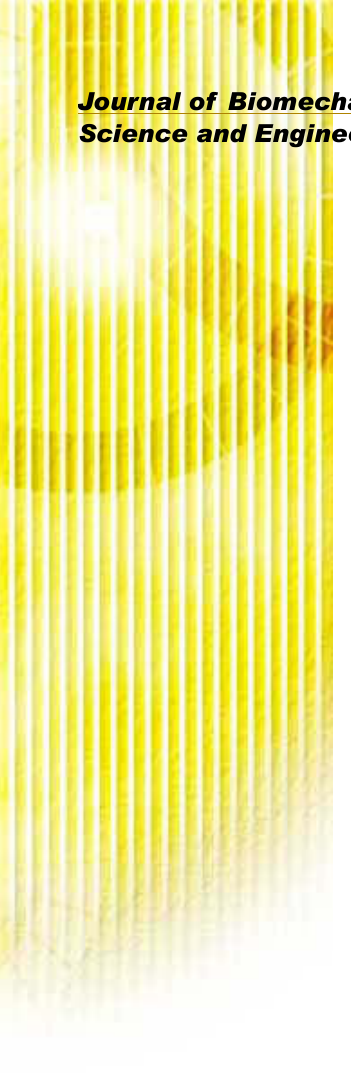
lines) in Fig. 7 is larger than that of the NH material (shown by the solid lines).